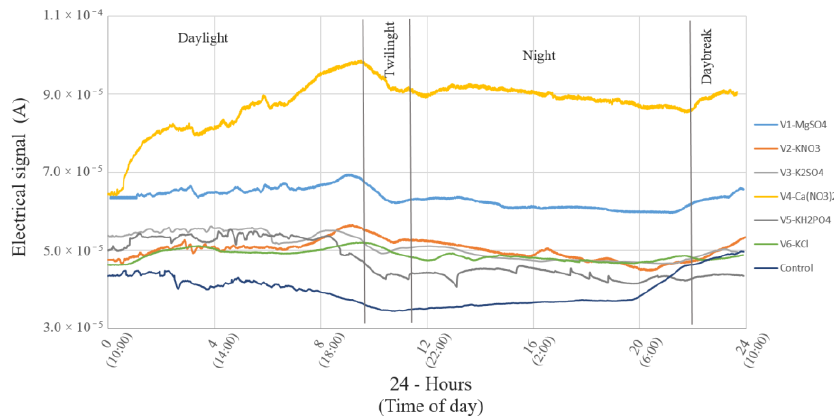
Figure 2. The unique daily imprint of the electrical signal generated by MgSO 4 (V 1 ), KNO 3 (V 2 ), K 2 SO 4 (V 3 ), Ca(NO 3 ) 2 (V 4 ), KH 2 PO 4 (V 5 ), KCl (V 6 ), and H 2 O (V11—control) in the tomato plants during 24